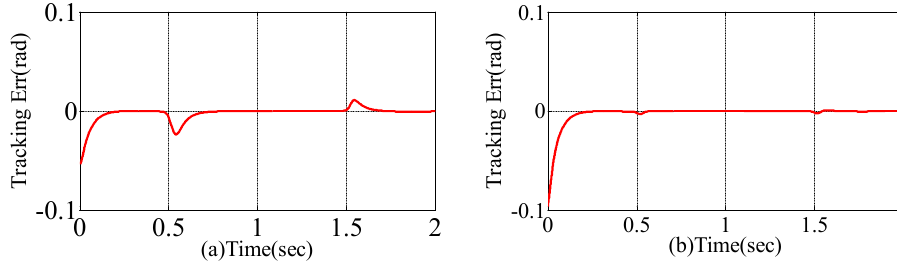
Figure 12. Joint angle tracking error: ( a ) Hip joint; ( b ) Knee joint.